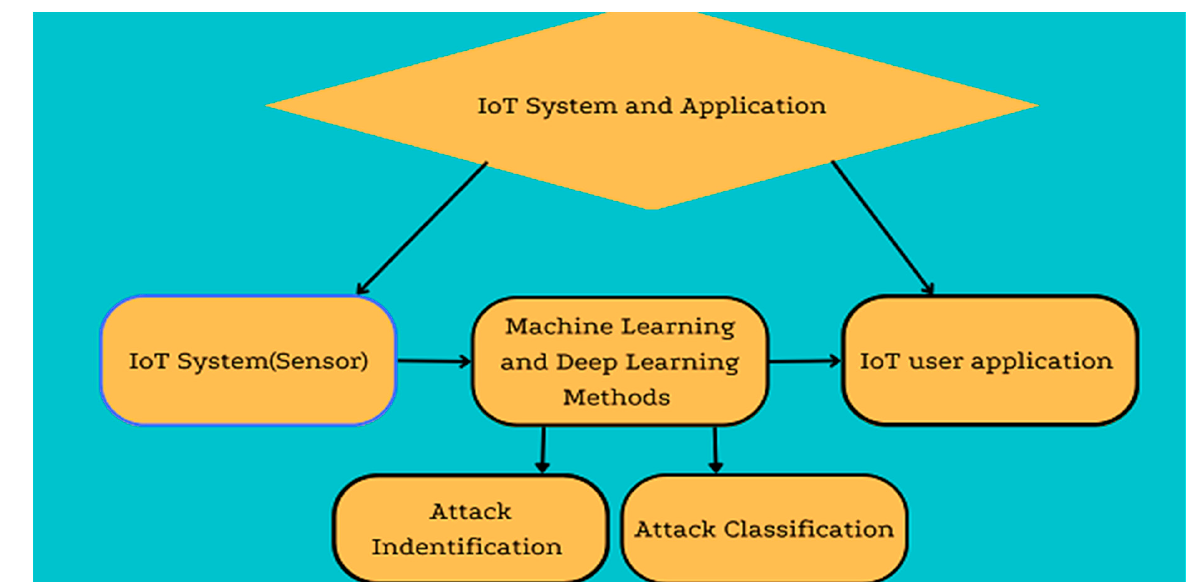
Figure 9. A machine learning security framework for IoT systems [96].